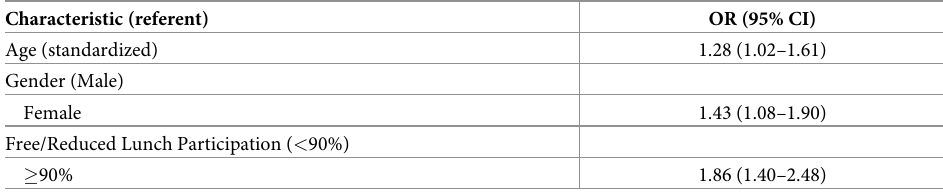
Table 7. Multivariate logistic regression model for any indirect violence exposure (Y/N) (N = 1548).